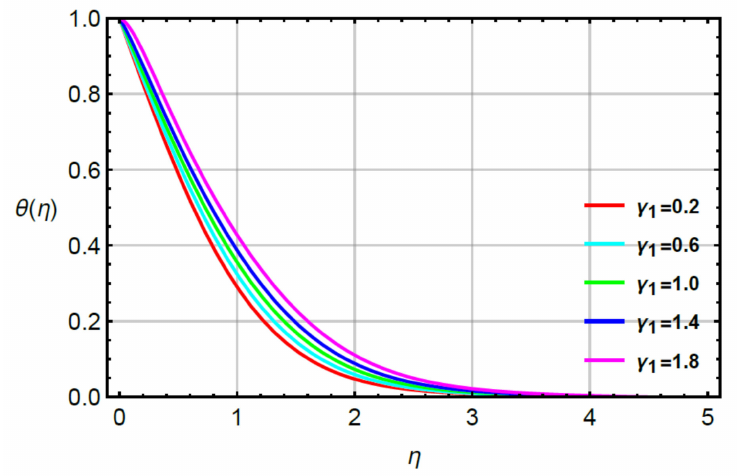
Figure 8. Behavior of θ ( η ) for γ 1 when R = 0.1, Sc = 0.6, Pr = 1.1, α 1 = 0.2 = α 2 , γ 2 = 0.3, M = 0.1, δ = 0.8.